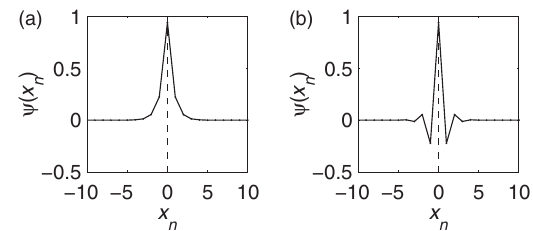
FIG. 6. Guided mode wave function (amplitudes as a function π =a and (b) the of x ) for ϕ ¼ π at (a) the highest band at k n y ¼ 0 . The calculation is based on N ¼ 1 in the lowest band at k y ¼ core region and 10 a on each side in the cladding